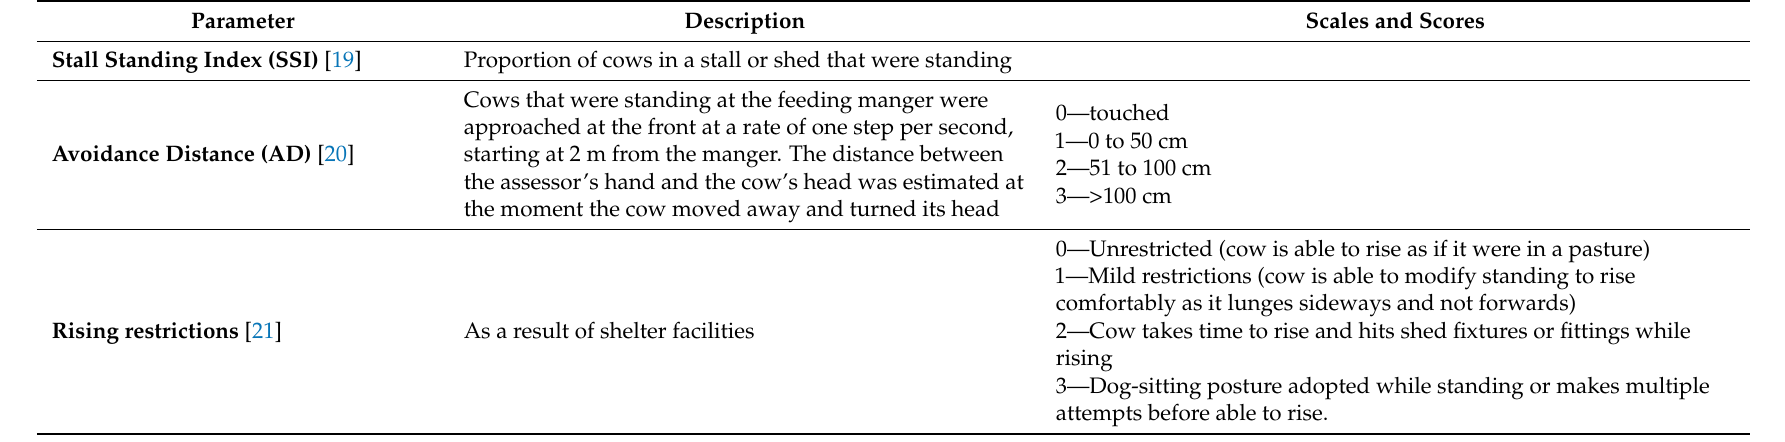
Table 2. Shelter animal-based parameters for assessment of association with coefficient of friction (CoF) of shed